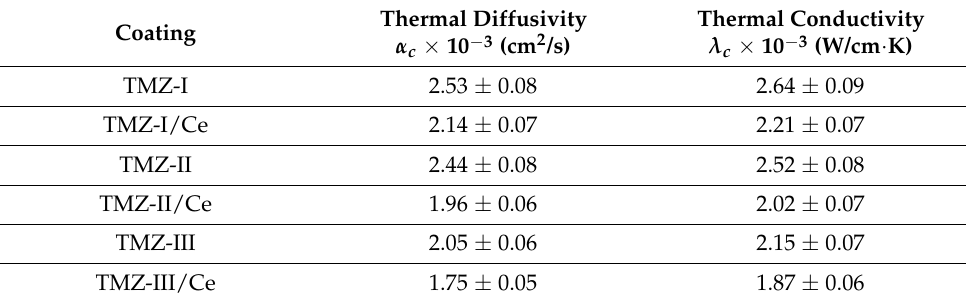
Figure 16. Amplitude and phase frequency dependence of TO for TMZ coatings. Table 2. Values of thermal parameters of TMZ coatings determined using BDS.